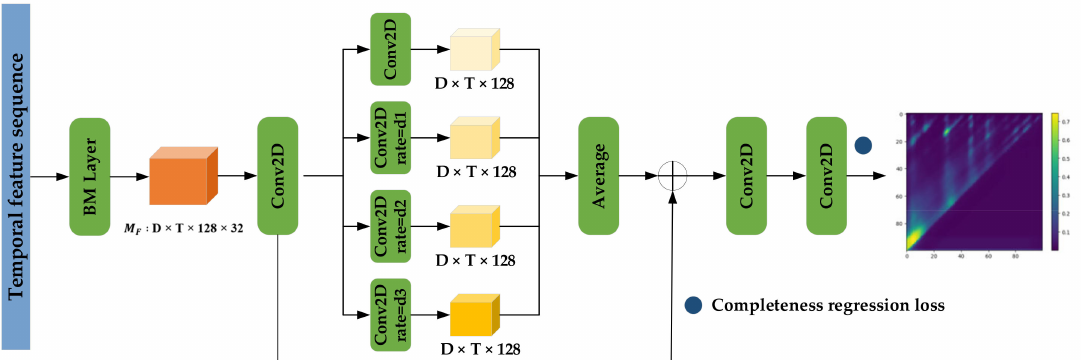
Figure 4. The architecture of Action Completeness Module (ACM). ACM evaluates the completeness of all densely distributed proposals.